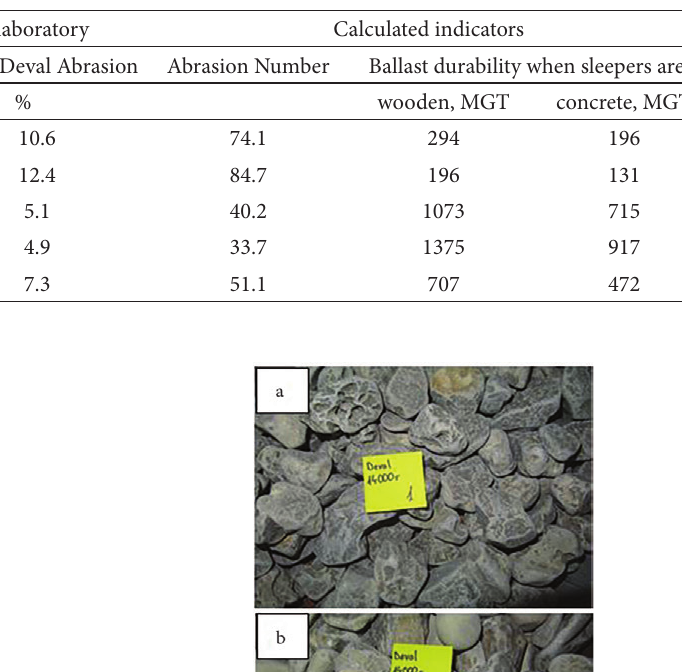
Table 1. Prognostic calculations results of ballast aggregate lifespan